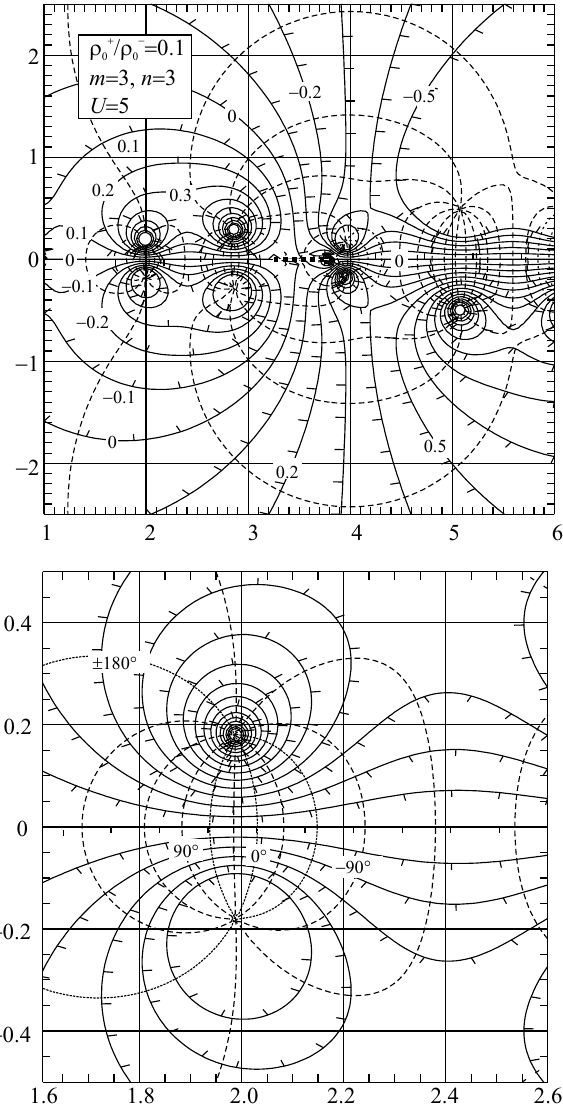
Fig. 8. Reflection coefficient in the complex plane when the mag- netopause plasma is in motion. The lower panel shows the detail of a portion of the upper panel. The full contours represent amplitude with the ticks showing the downhill direction. The contours are drawn for log | R |= 0 . 1 n where n = 0 , ± 1 , ± 2 , ± 3 ,... . The heavy dotted line is a branch cut. The dashed lines are contours of con- stant phase drawn at 30 ◦ intervals.